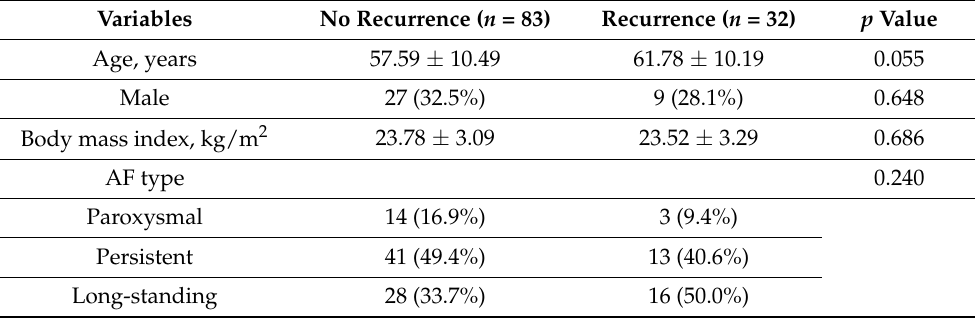
Table 3. Comparisons between the sinus group and the atrial fibrillation recurrence